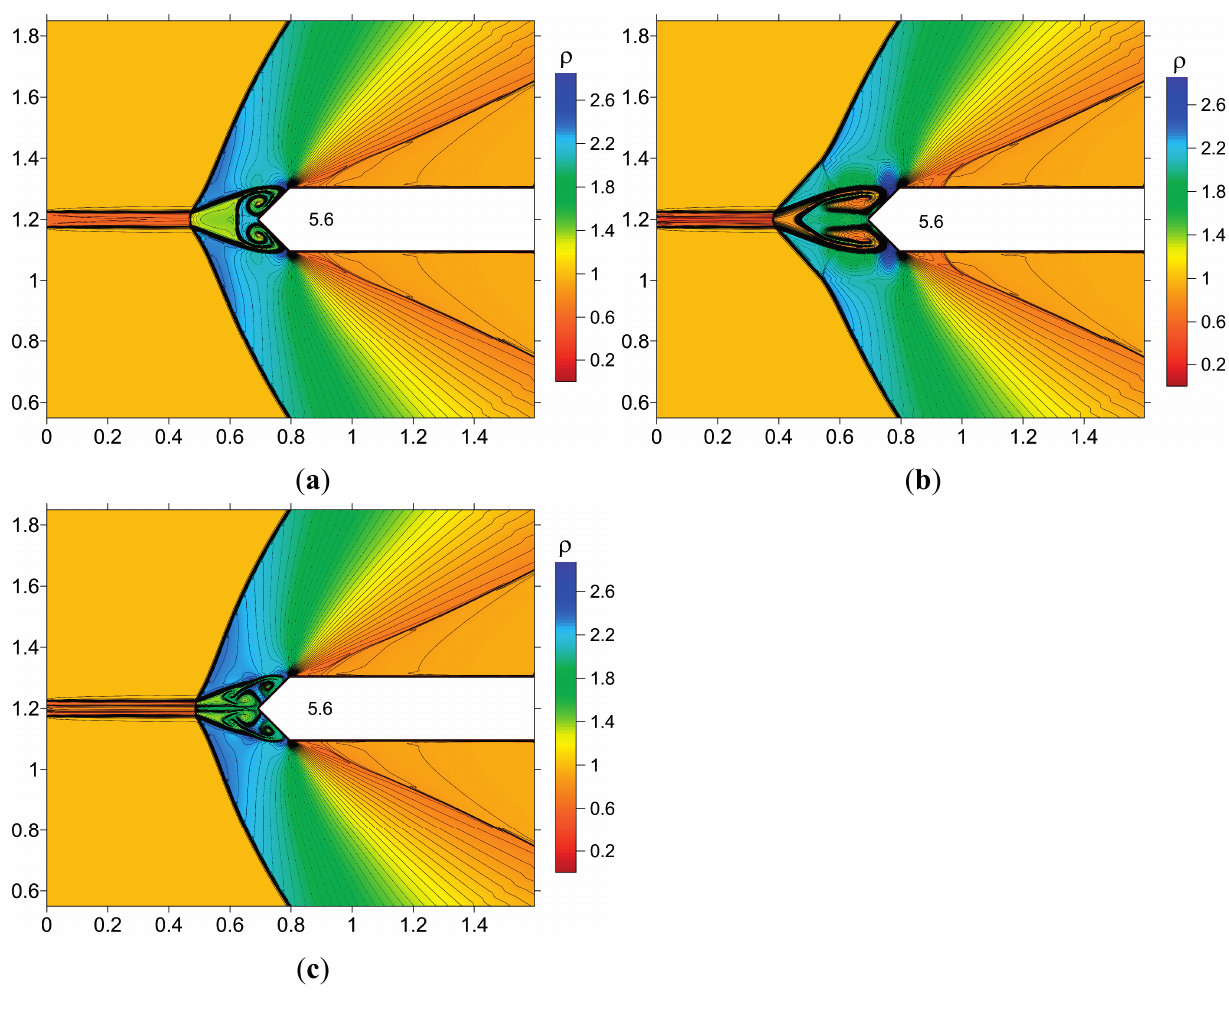
Figure 10. Unsteady vortex structures in front of the body: density, α ρ = 0.6: ( a ) Non-combined filament; ( b ) Combined filament, α ρ 1 = 0.4; ( c ) Combined filament, α ρ 1 =